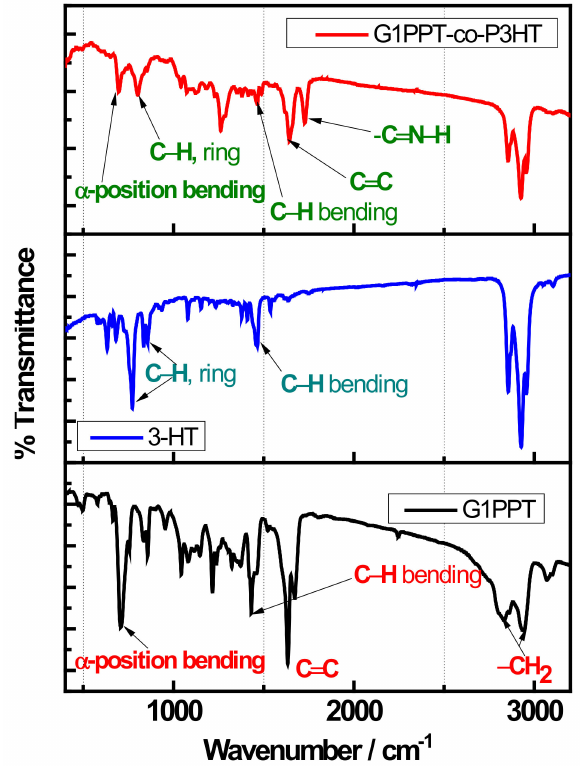
Figure 2. FTIR spectra of G1PPT-co-P3HT, 3-HT, and G1PPT [1]. Table 1. Molecular vibrational frequencies in G1PPT-co-P3HT, 3-HT, and G1PPT